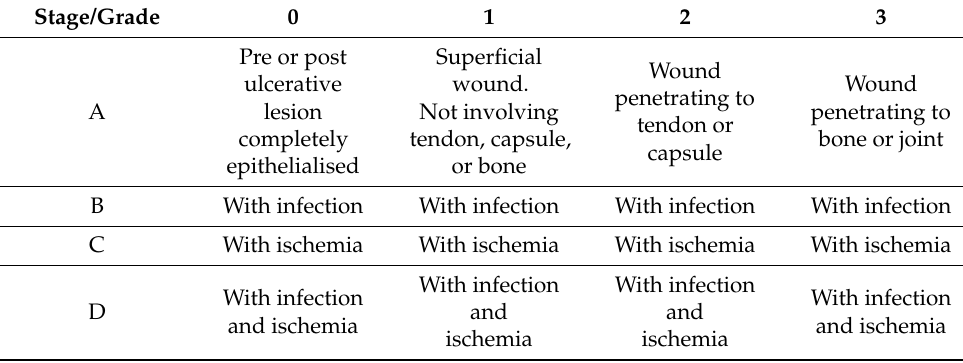
Table 3. University of Texas foot ulcer